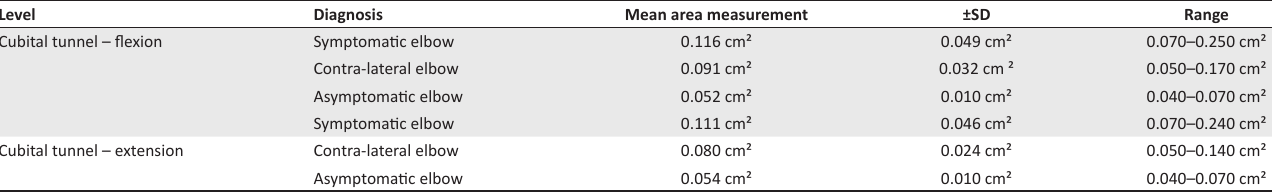
FIGURE 8: Ulnar nerve cross-sectional area measurement ranges in the cubital tunnel (flexion). FIGURE 9: Ulnar nerve cross-sectional area measurement in the cubital tunnel (extension). TABLE 1a: Comparison of ulnar nerve measurements in symptomatic versus contra-lateral elbow and asymptomatic participants at the level of the cubital tunnel.